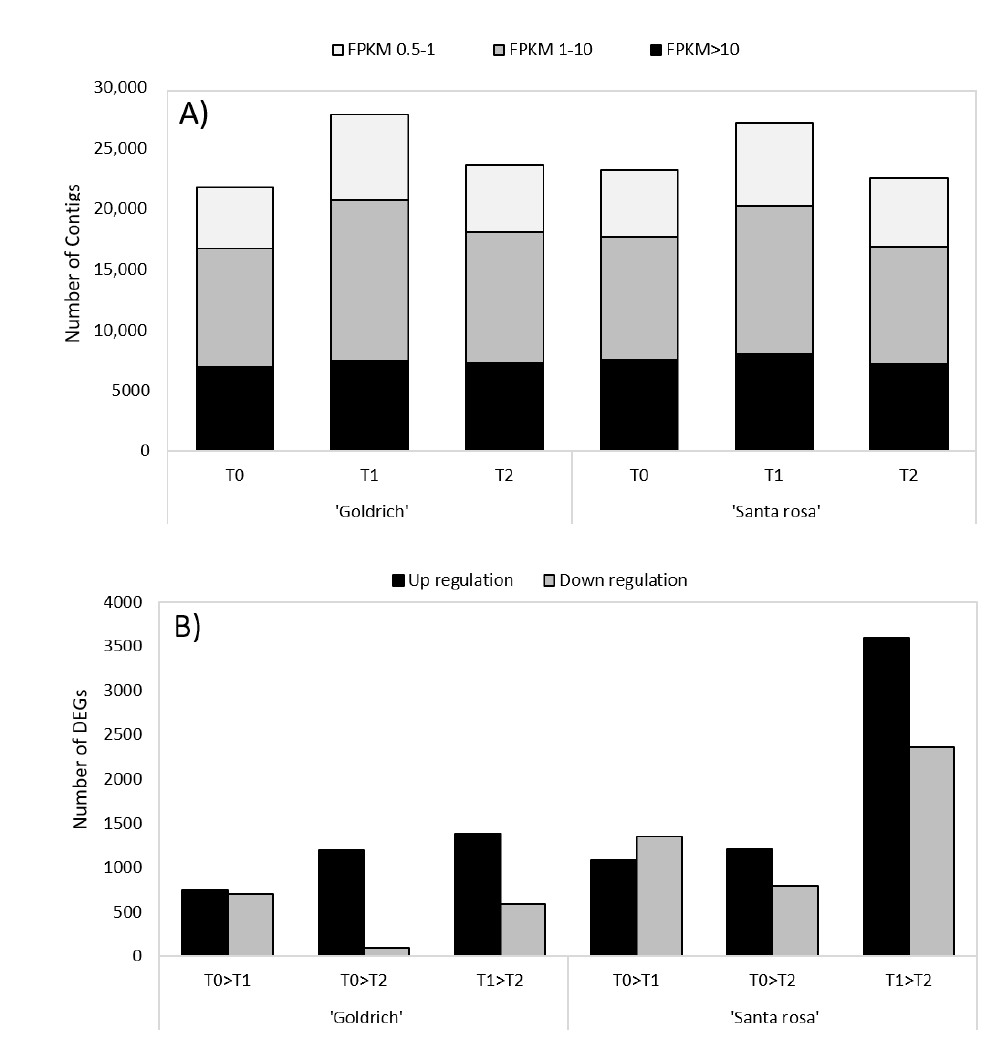
Figure 3. ( A ) Summary of the global gene expression in apricot ‘Goldrich’ and Japanese plum ‘Santa Rosa’ for different treatments (control, T0; 1-MCP, T1; Ethrel, T2) and ( B ) the number of up and down regulation DEGs ( − 1 > log2FC > 1; p -value < 0.005) for each treatment comparison (T0 vs. T1, T0 vs. T2, and T1 vs. T2).